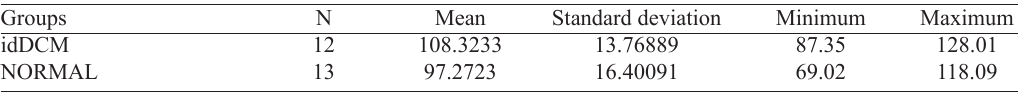
Table 4. Descriptive measures of variables LVR perimeter in idDCM and Normal (mm) groups. Groups